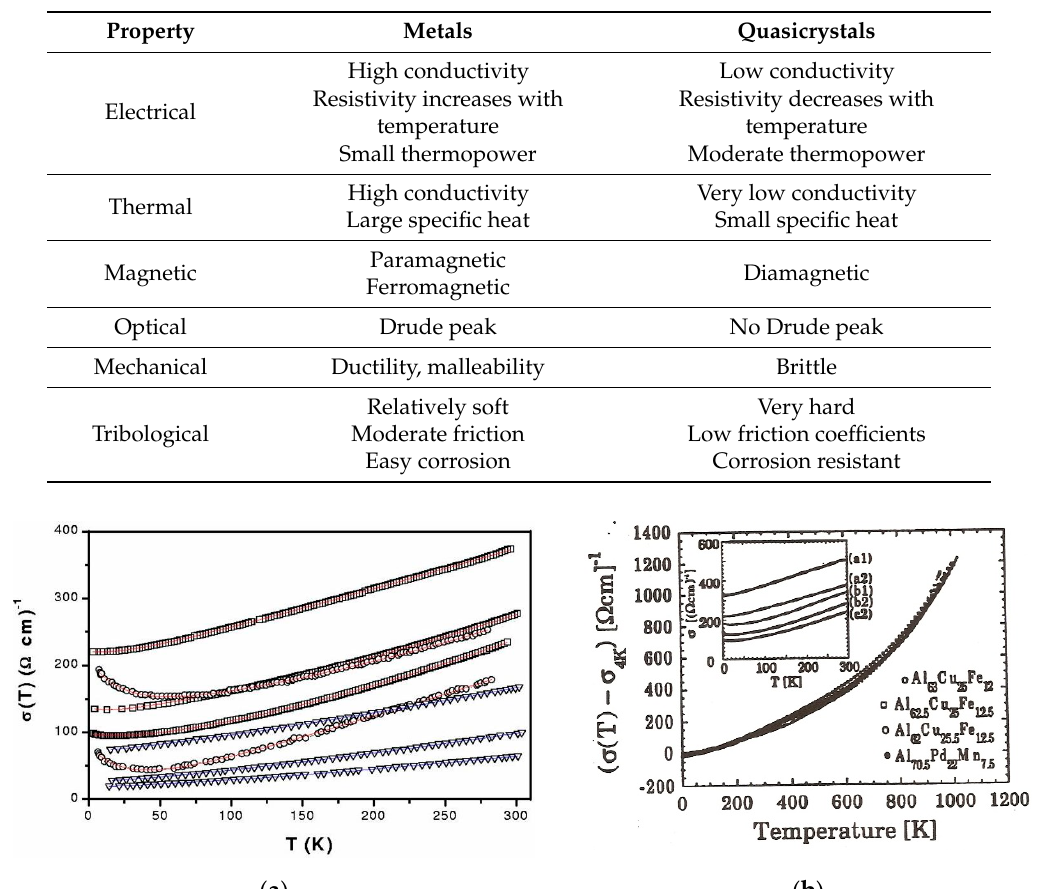
Table 1. Comparison between the physical properties of typical metallic compounds and QC alloys.